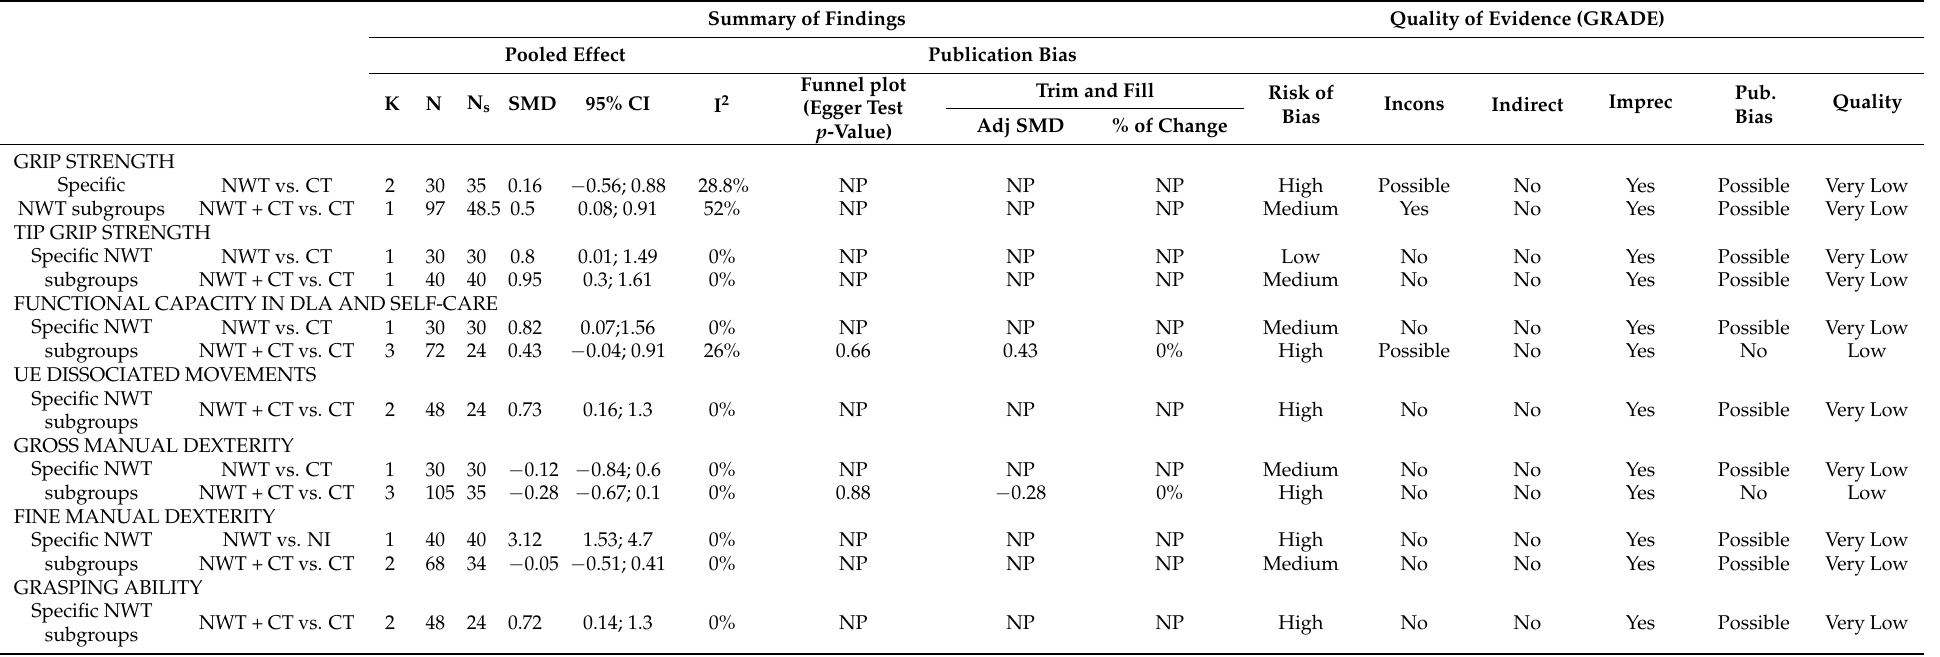
Table 5. Main findings in